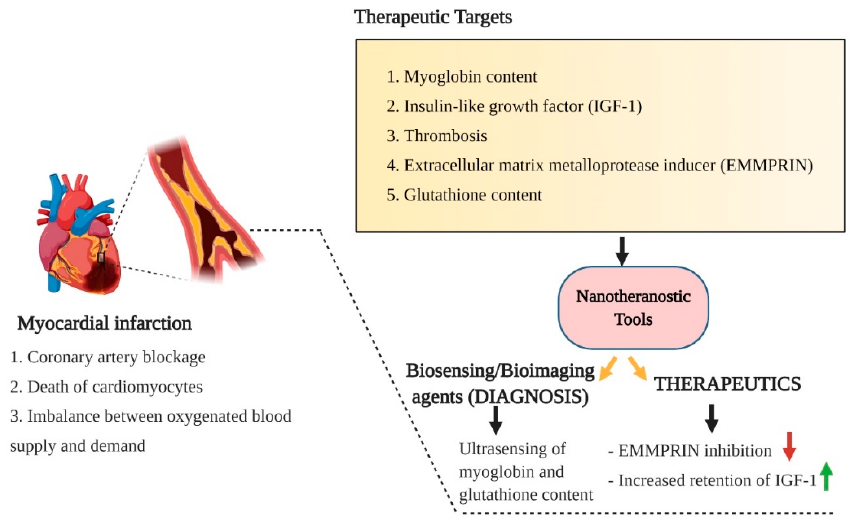
Figure 5. A schematic overview of the pathophysiological risk factors associated with myocardial infarction (heart attack), important healthcare settings in CVDs and the potential pathophysiological targets for early diagnosis and therapy of myocardial infarction using nanotheranostic